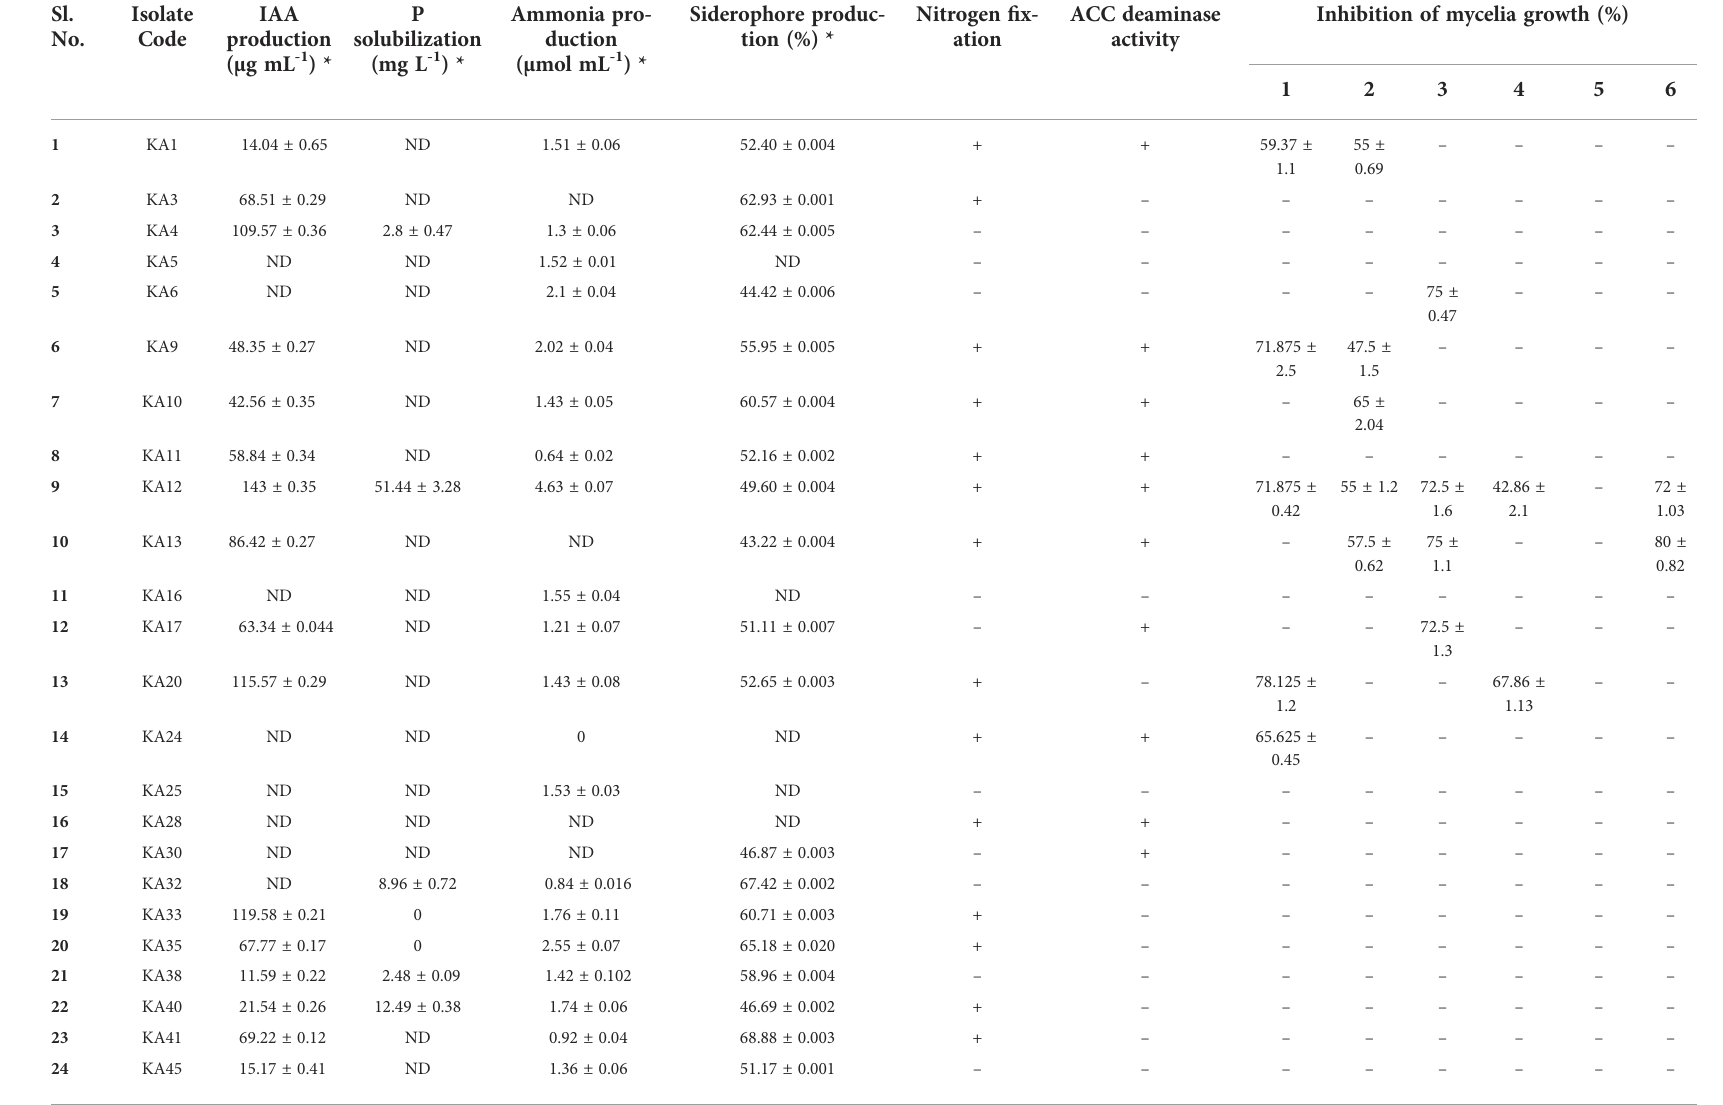
TABLE 2 In vitro plant growth-promoting and antifungal traits shown by endophytic actinobacterial isolates. Sl.